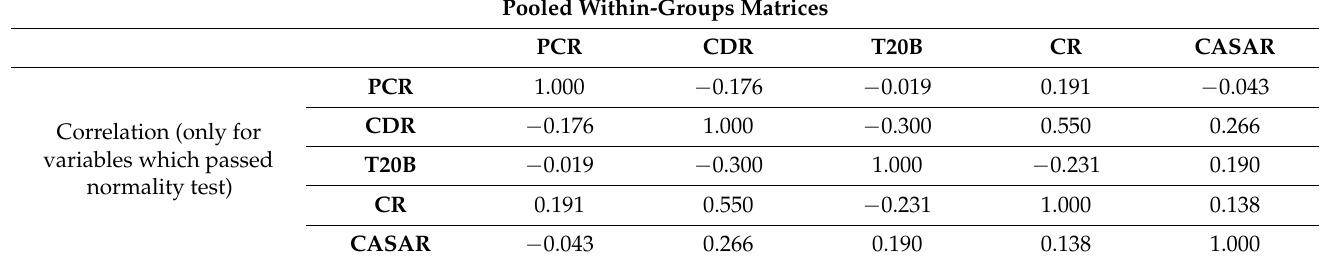
Table A9. Box’s M.